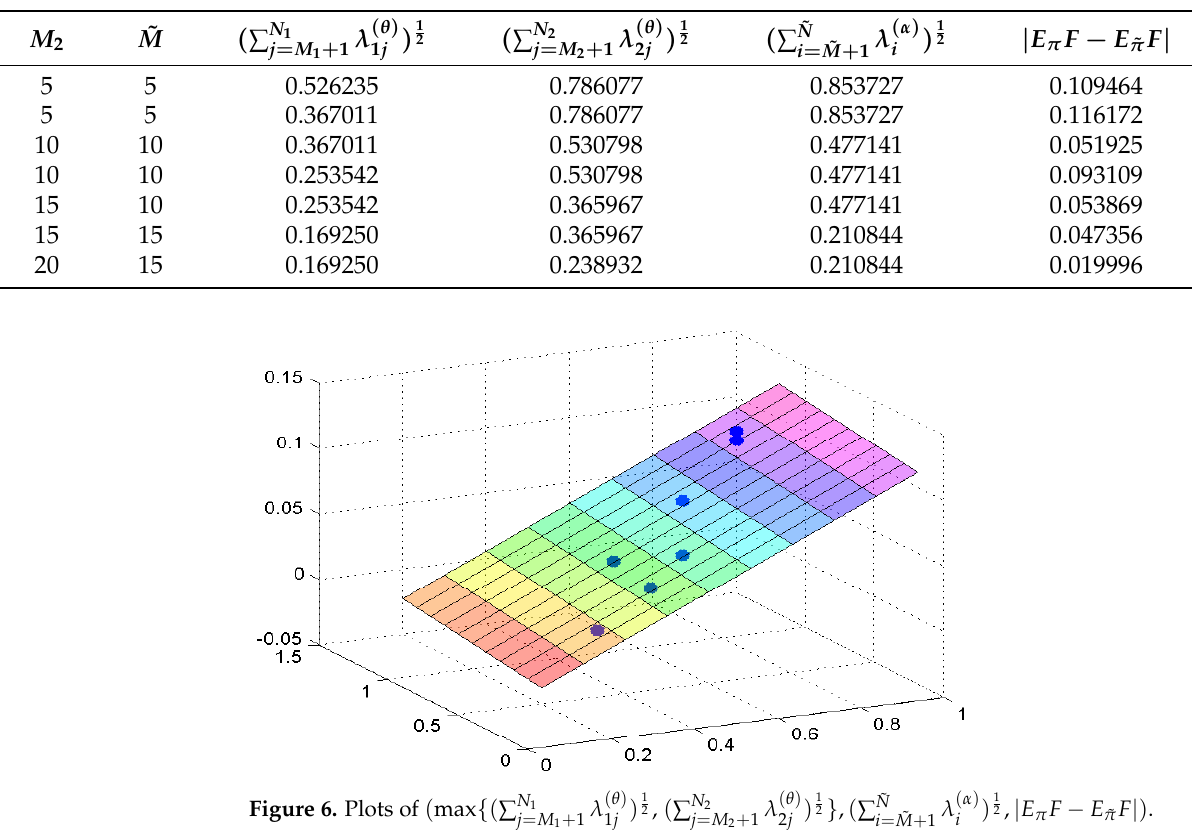
Table 3. Posterior errors